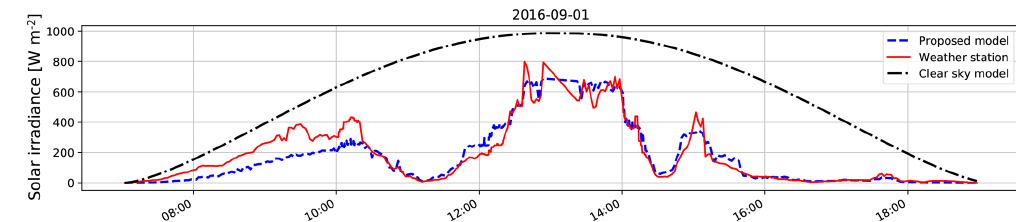
Figure 8. Measured weather station data (in red) vs. clear-sky radiation (in black) on 1 September 2016. The sampling interval between two measurements is 2min.